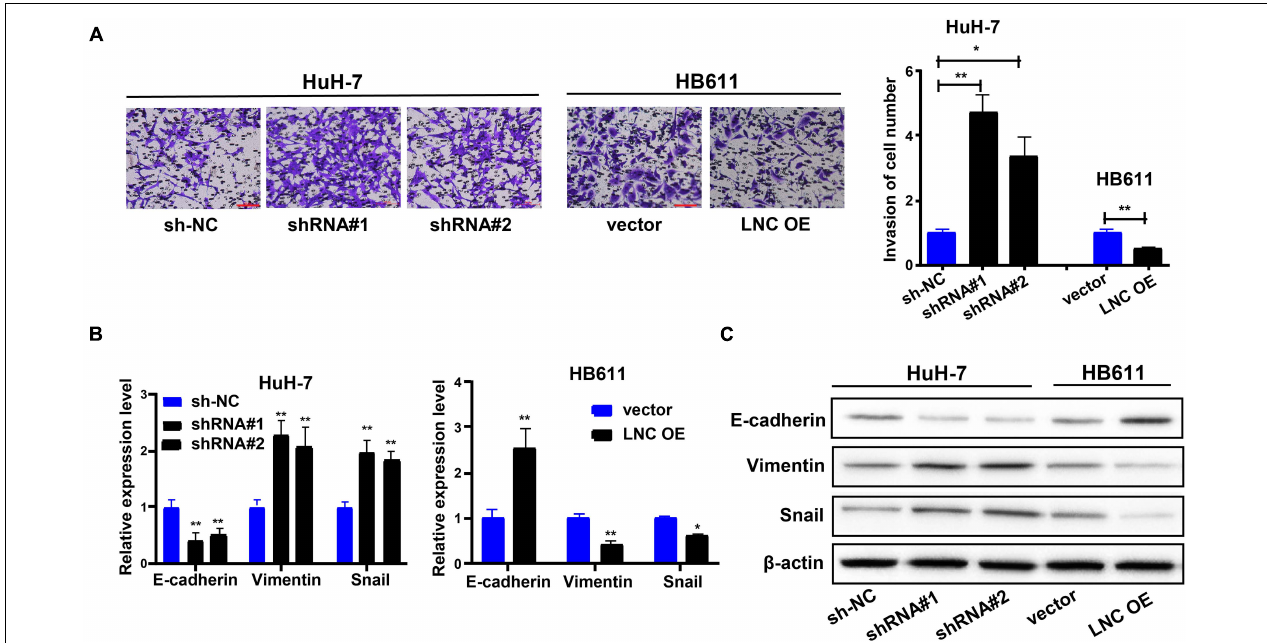
FIGURE 3 | TMEM220-AS1 inhibits the cell invasion and EMT of HCC cells. (A) Cell invasion was determined using Transwell assay (bar = 100 µ m). (B,C) The expression of EMT markers were determined using qRT-PCR and western blot assay. Data were presented as represent the mean ± SD of 3 independent experiments; * P < 0.05, ** P <